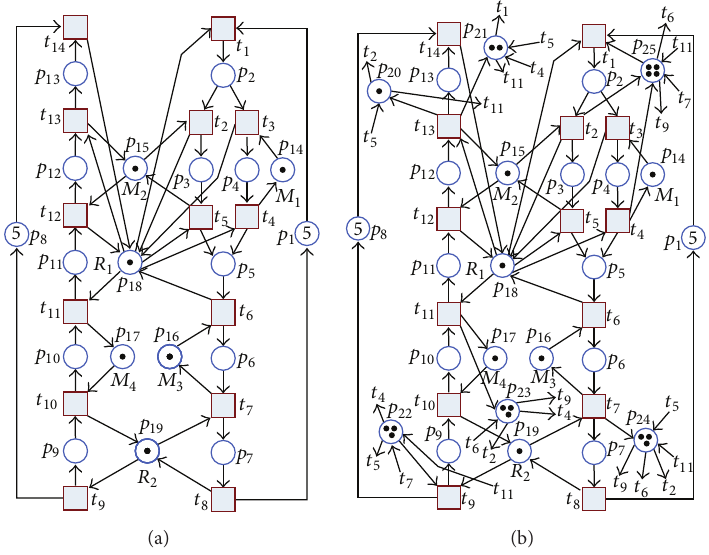
Figure 6: (a) Petri net model of an FMS and (b) structure of the controlled